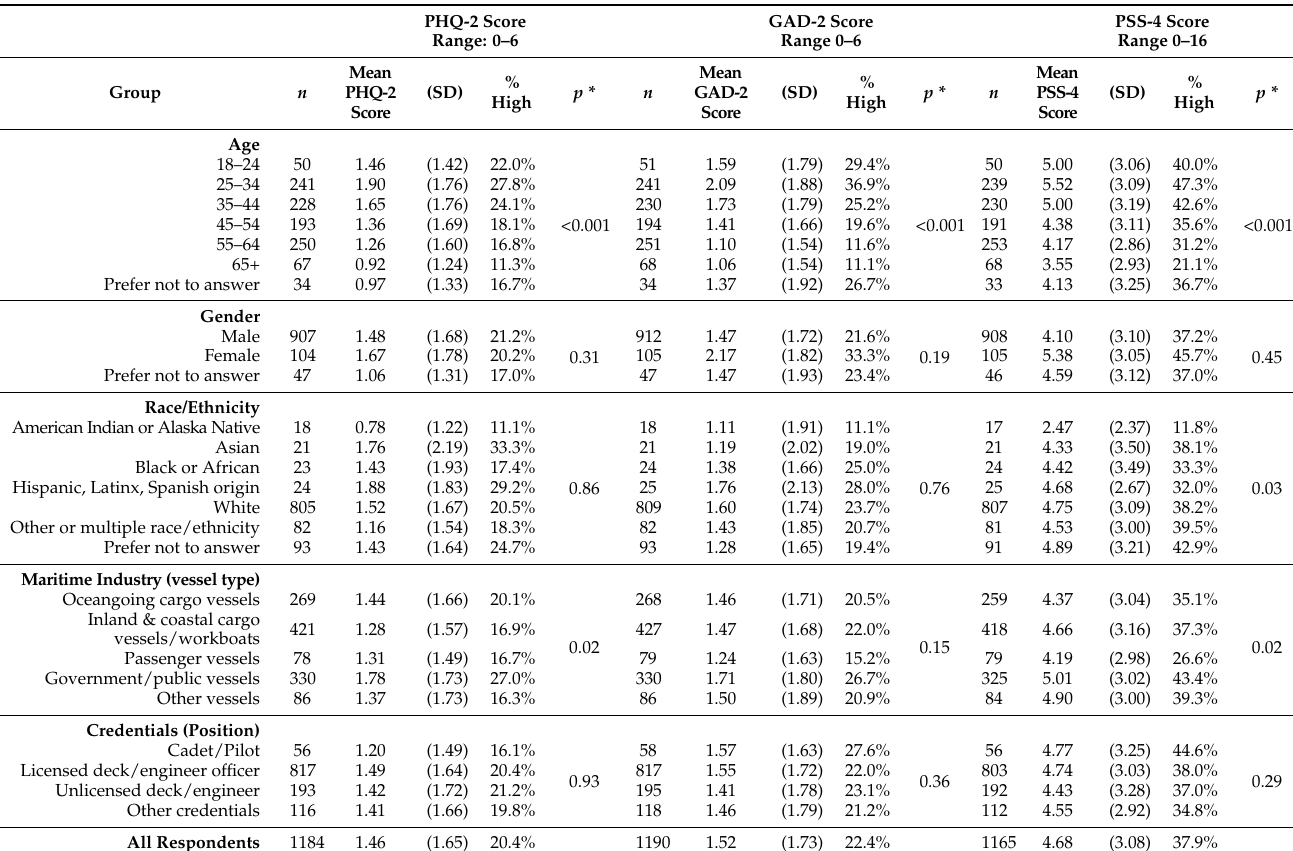
Table 2. Distribution of outcomes by demographic factors.